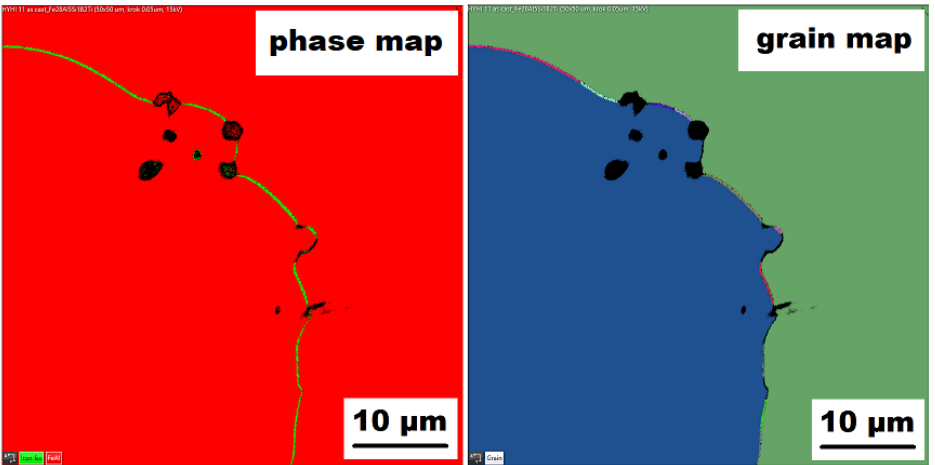
Figure 9. The EBSD phase and grain maps showing the gamma-iron presence in Fe – 28Al – 5Si – 2Ti – 1B as-cast alloy (green areas in phase maps).